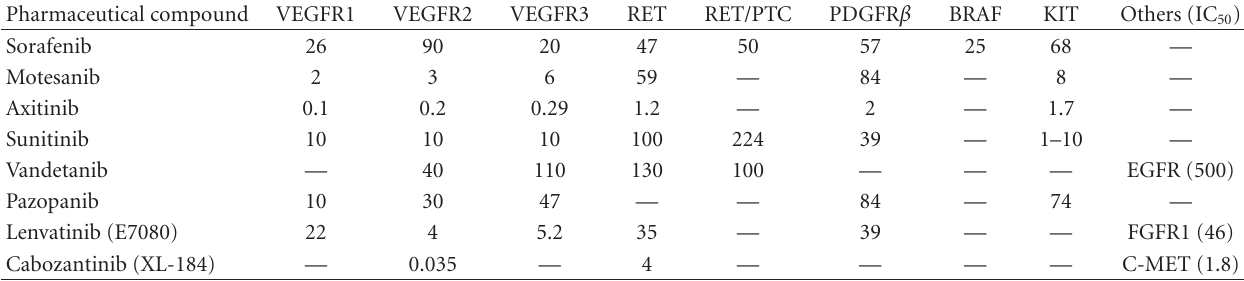
Table 1: Inhibitory concentration 50 (IC 50 ) of the major pharmaceutical compounds in clinical development for the treatment of thyroid cancer segregated with respect to the kinase activity required to inhibit di ff erent molecular targets (nmol/L). Pharmaceutical